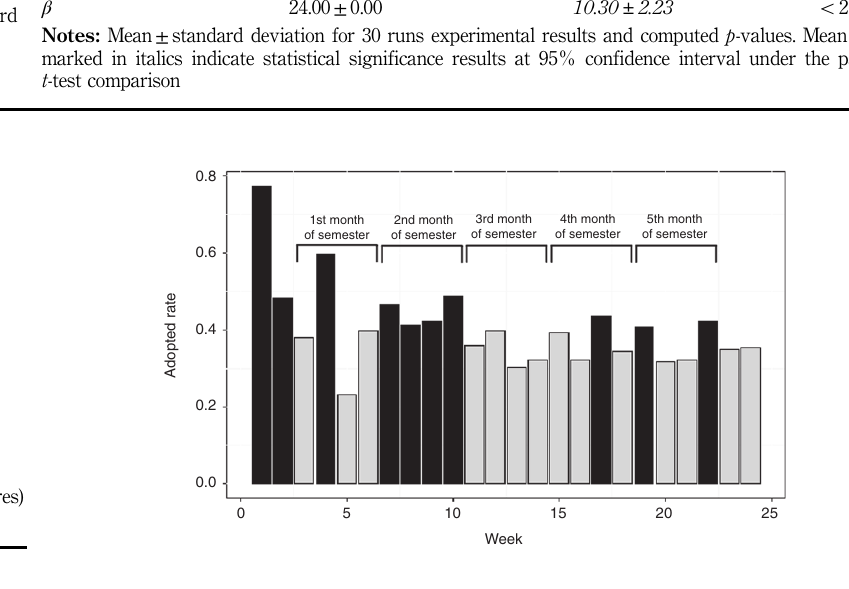
Table II. Numerical results comparing the accuracy rate and number of features between the standard C4.5 classifier and proposed model on